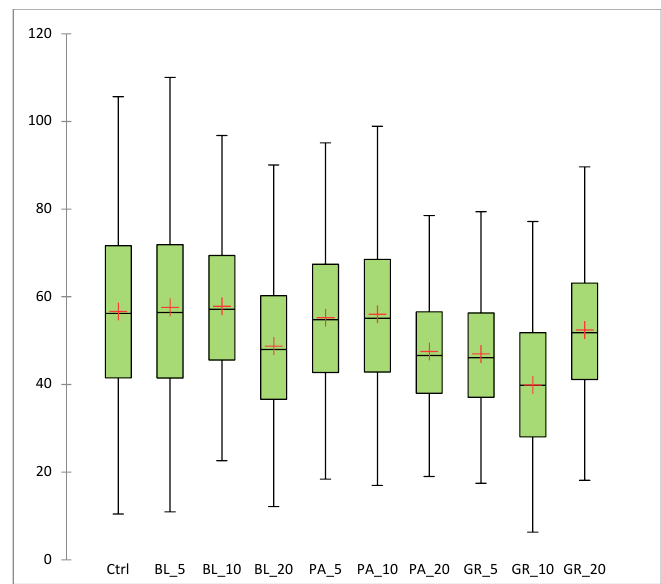
(490.09 nm 2 on average) and PA_5 (618.54 nm 2 on average). A statistically significant dif-